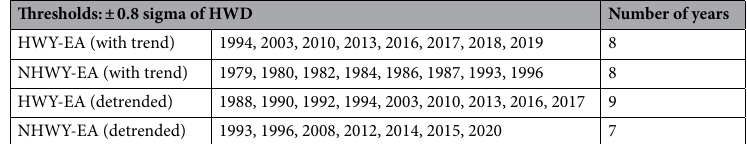
Table 1. Heatwave and non-heatwave years in East Asia (HWY-EA and NHWY-EA) were defined by the ± 0.8 standard deviation thresholds of the HWD with the trend and detrended HWD,